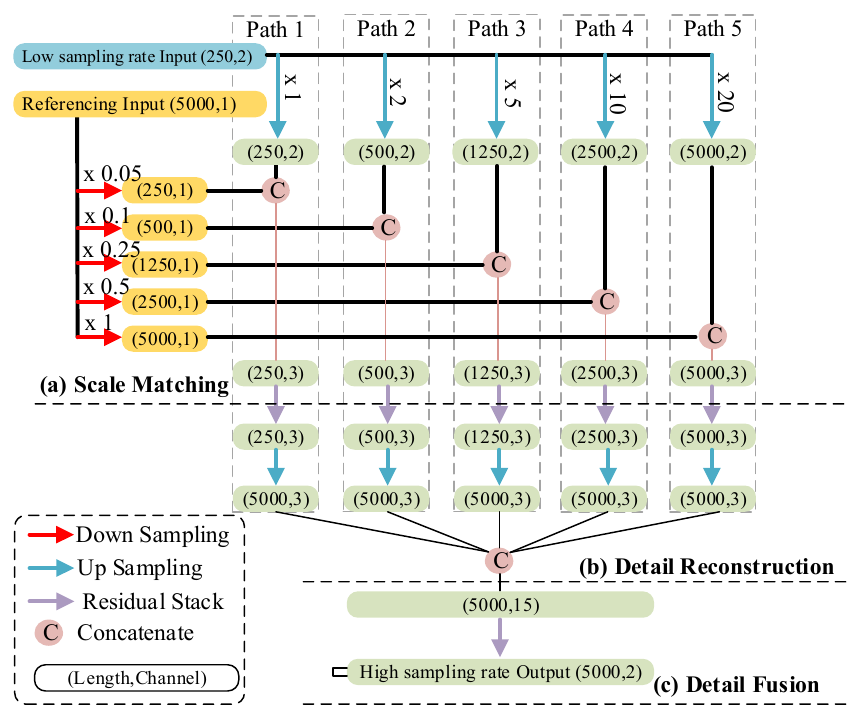
Figure 4. Structure of the signal-referenced network. The capsule represents the length and channels of each feature map. The arrows with a different color are explained in the rectangular box in the bottom left. The label (Path 1 to Path 5) indicates the path to reconstruction of a fixed-length feature map. The length of the inpu tt ing and outpu tt ing signals is 10 seconds.